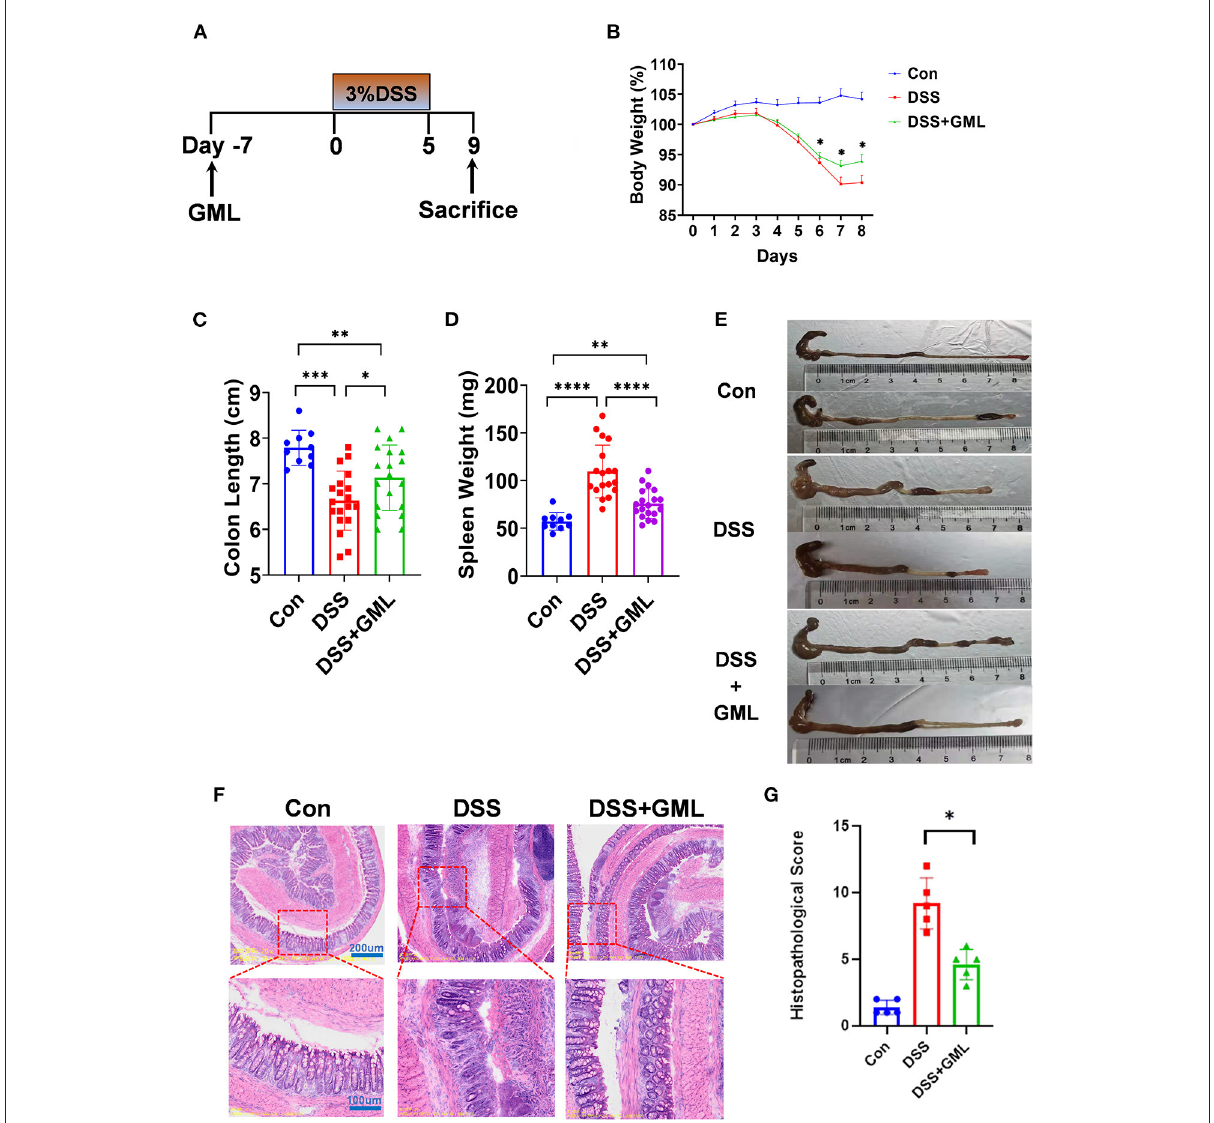
FIGURE1 Oral administration of GML alleviated DSS-induced acute colitis symptoms in mice. (A) Experimental design and arrangement. (B) The body weight of the mice was assessed throughout the experiment and is expressed as a percentage change relative to the initial body weight before DSS administration. (C,E) The colon length was measured. (D) The spleen weight was measured. (F) The distal colon was stained with HE. (G) Histopathological score. The data are expressed as the means ± SEMs (Con group n = 10, DSS group n = 20, DSS + GML group n = 20). * P < 0.05; ** P < 0.01; *** P < 0.001; **** P < 0.0001.